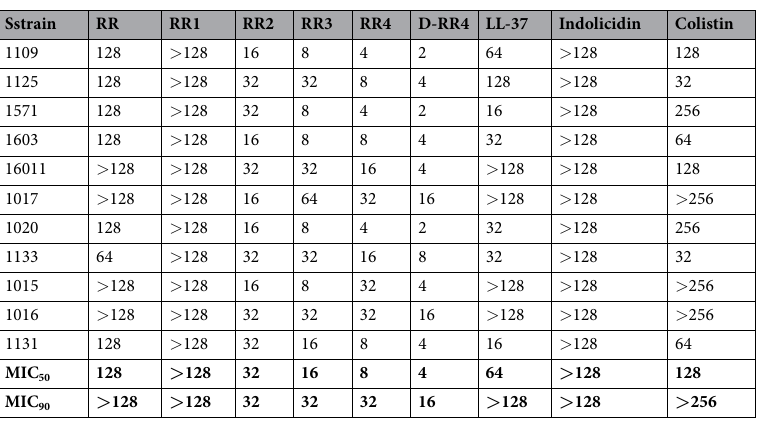
Table 3. Minimum inhibitory concentration (MIC) ( µ M) of peptides against clinical isolates of colistin- resistant P. aeruginosa isolated from cystic fibrosis